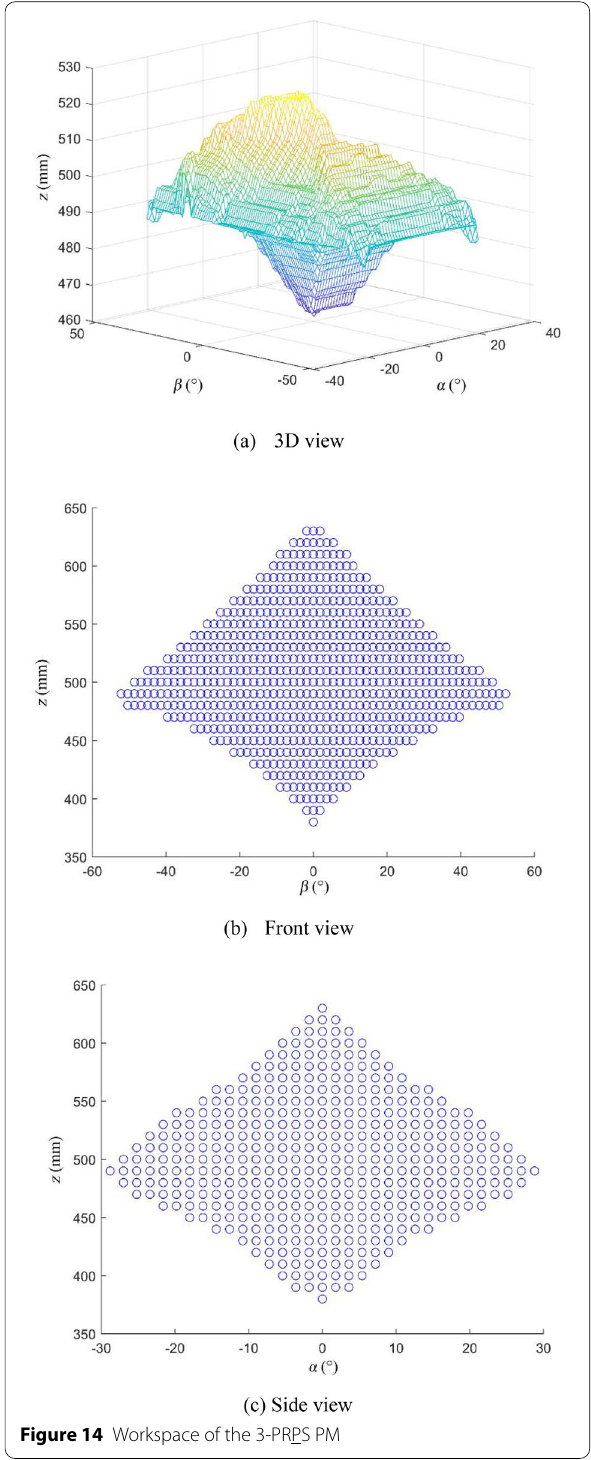
Figure 14 Workspace of the 3-PRPS